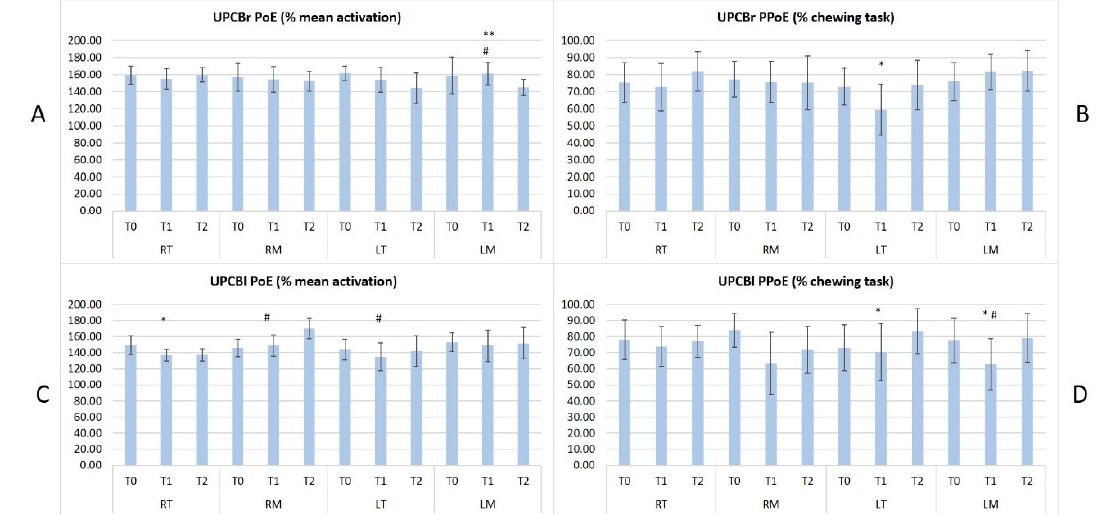
Figure 4. the results of a paired T Test (p < 0.05) at T0, T1 and T2 in both UPCBl in the upper graphs ( A , B ), and in UPCBr in the lower graphs ( C , D ).